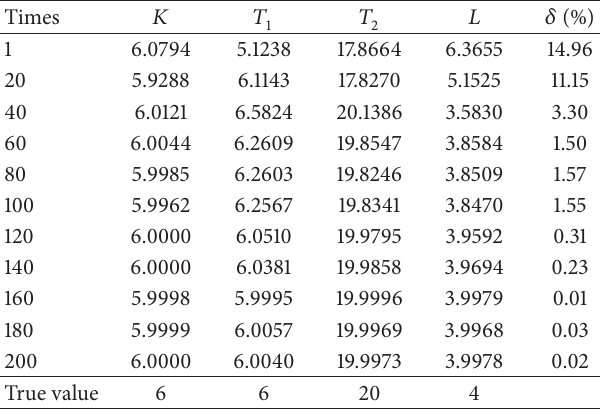
Figure 5: The step response of the system transfer function